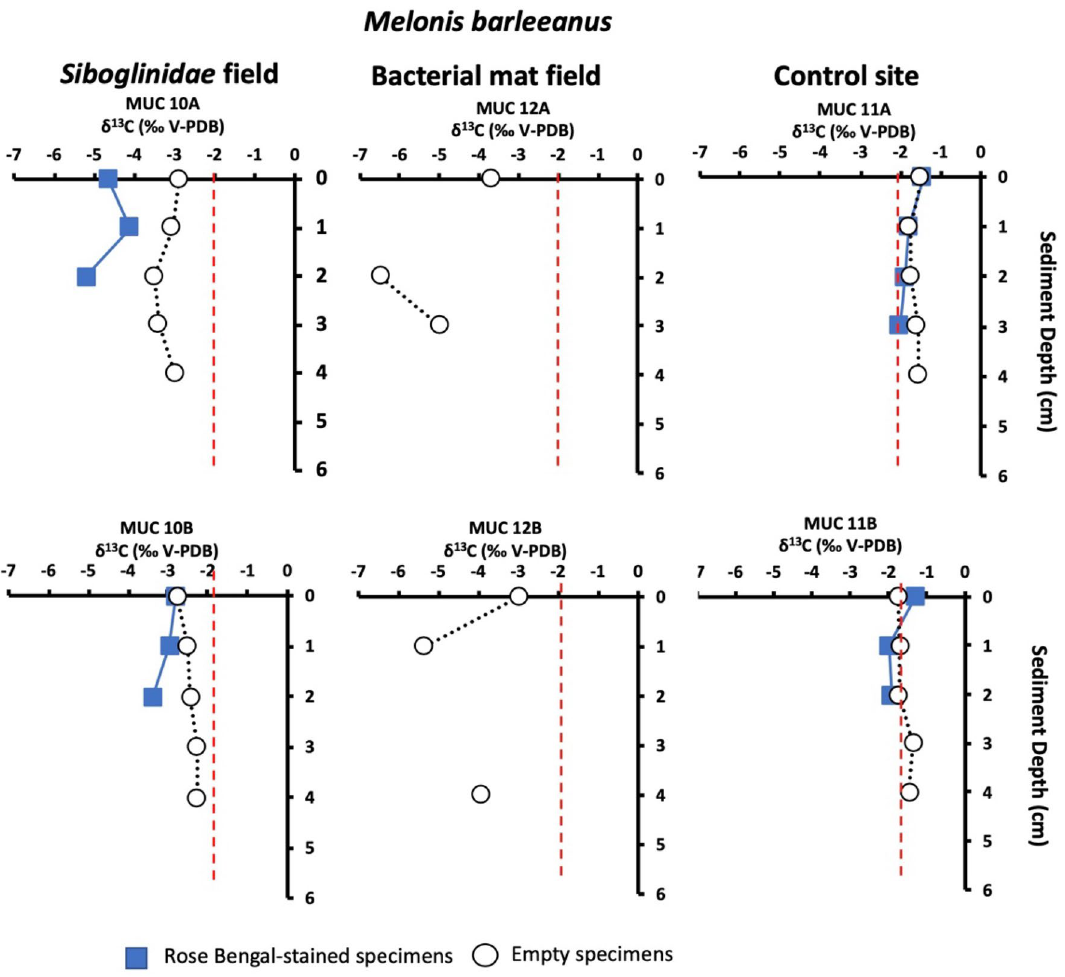
Figure 3. Carbon isotope values (δ 13 C) of Melonis barleeanus in sediment from the Siboglinidae field (MUC 10A and MUC 10B), bacterial mat field (MUC 12A and MUC 12B), and control site (MUC 11A and MUC 11B). The vertical red line indicates the δ 13 C minimum value for non-seep conditions 34